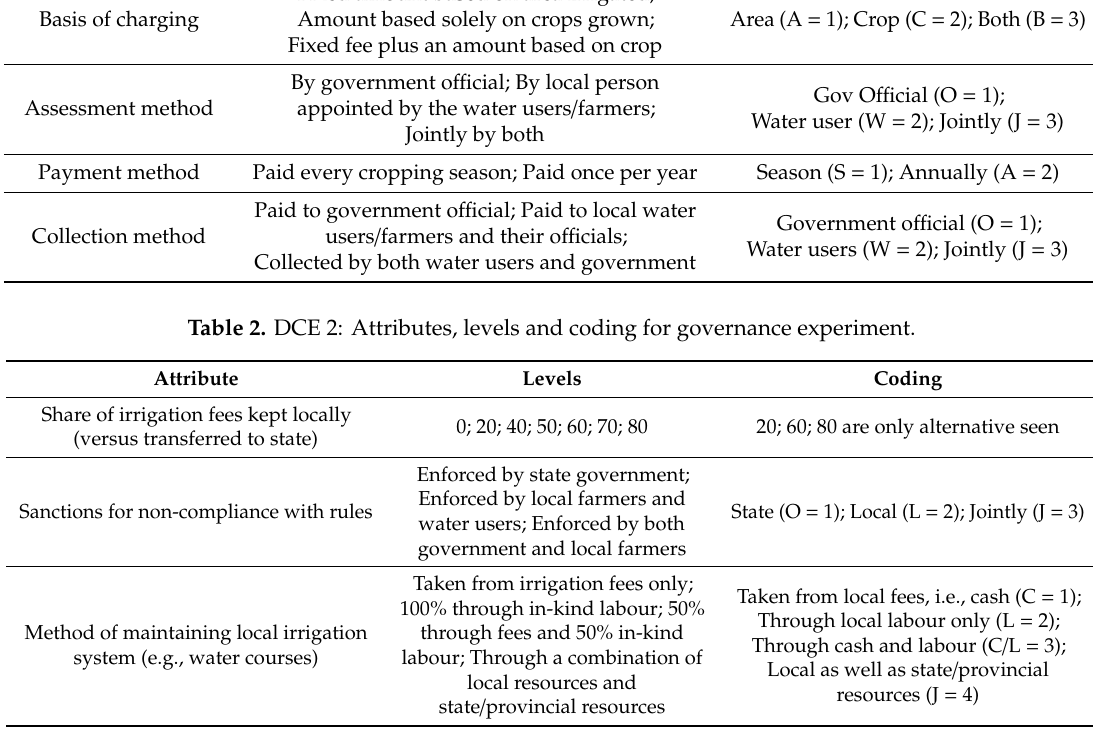
Table 1. Discrete Choice Experiment (DCE) 1: Attributes, levels and coding for payment experiment. Attribute Levels Coding Basis of charging